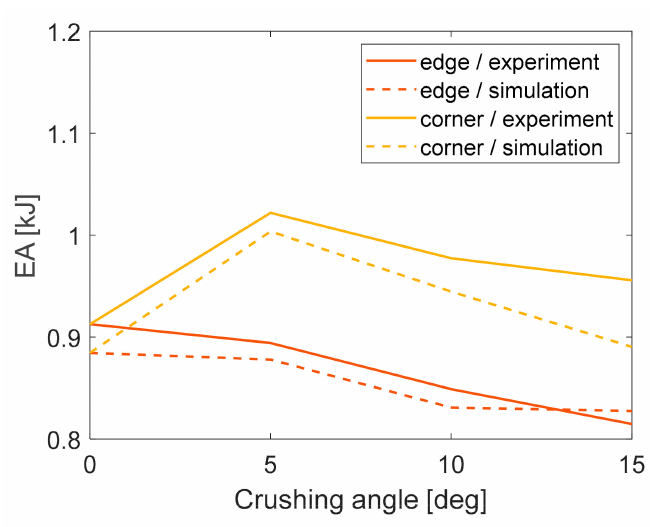
Figure 19. EA variation with crushing